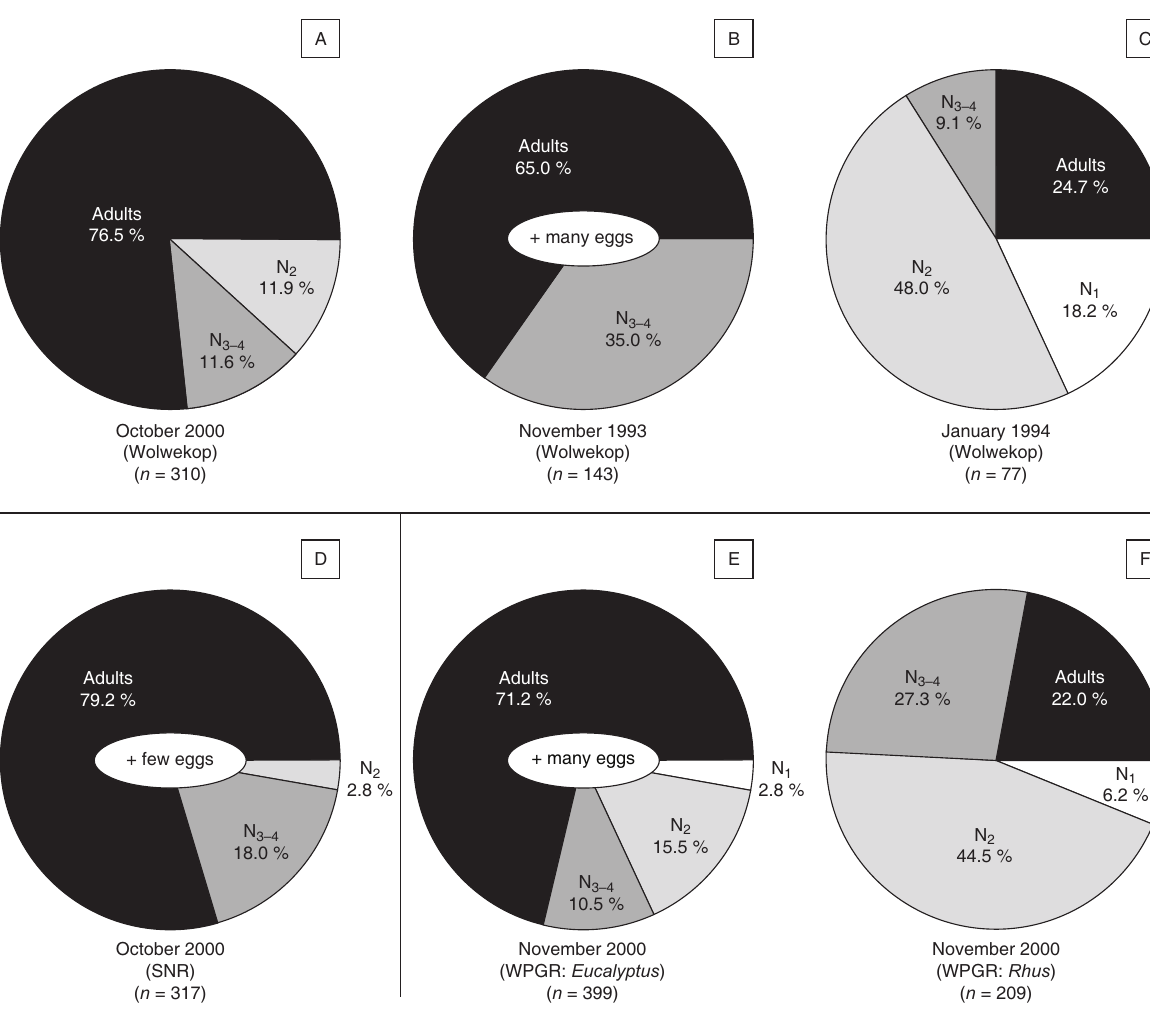
The 209 ticks collected from Rhus sp. shrubs in which the sacred ibis nests with young nestlings were located were composed of N (71.8 %), and adult ticks were much less common (Fig. 1F). The sex ratio of adults was close to parity (52 % males and 48 % females). N were present, but no larvae were observed in either of the two samples (Fig. 1E and